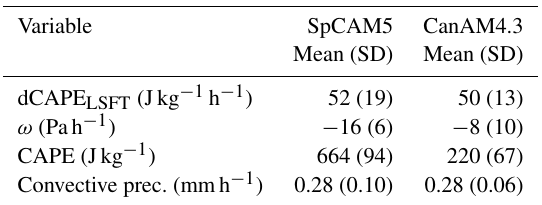
Table 1. Domain (150–170 ◦ E and 0–10 ◦ N) and time (May–July 1997) means for spCAM5 and CanAM4.3 along with spatial stan- dard deviations (in brackets) that were computed using the time mean distributions over the